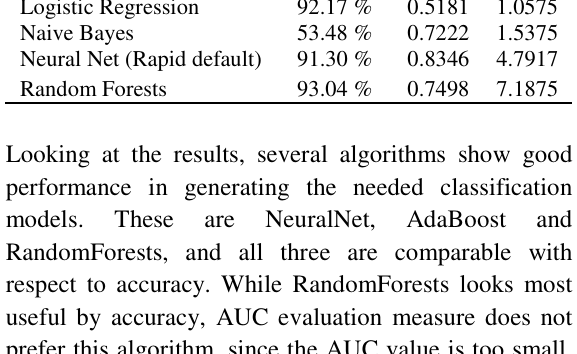
Fig. 2. Preprocessing steps in the training phase, for the selected algorithms